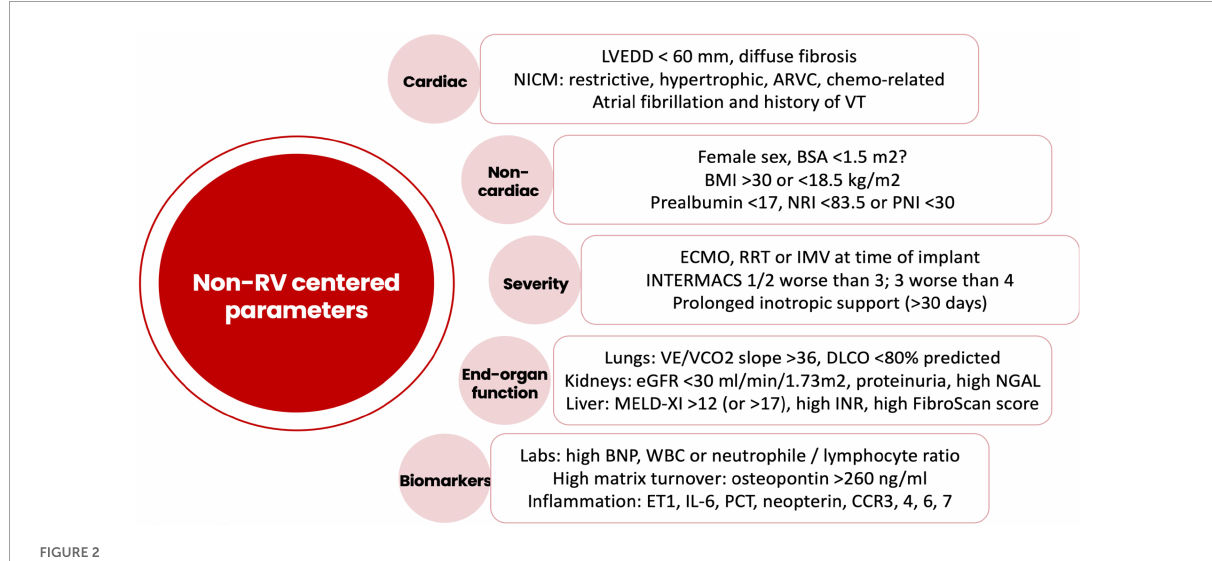
FIGURE2 Risk factors for right ventricular failure after LVAD implantation not related to the intrinsic right ventricular function. LVEDD, left ventricular end-diastolic diameter; NICM, non-ischemic cardiomyopathy; ARVC, arrhythmogenic right ventricular cardiomyopathy; VT, ventricular tachycardia; BSA, body surface area; BMI, body mass index; NRI, nutrition risk index; PNI, prognostic nutrition index; ECMO, extracorporeal membrane oxygenation; RRT, renal replacement therapy; IMV, invasive mechanical ventilation; INTERMACS, interagency registry for mechanically assisted circulatory support; VE, minute ventilation; VCO2, carbon dioxide production; DLCO, carbon monoxide diffusion capacity; eGFR, estimated glomerular filtration rate; NGAL, neutrophil gelatinase-associated lipocalin; MELD, model for end-stage liver disease; INR, international normalized ratio; BNP, brain natriuretic peptide; ET1, endothelin 1; IL6, interleukin-6; PCT, procalcitonin; CCR, CC chemokine receptor.